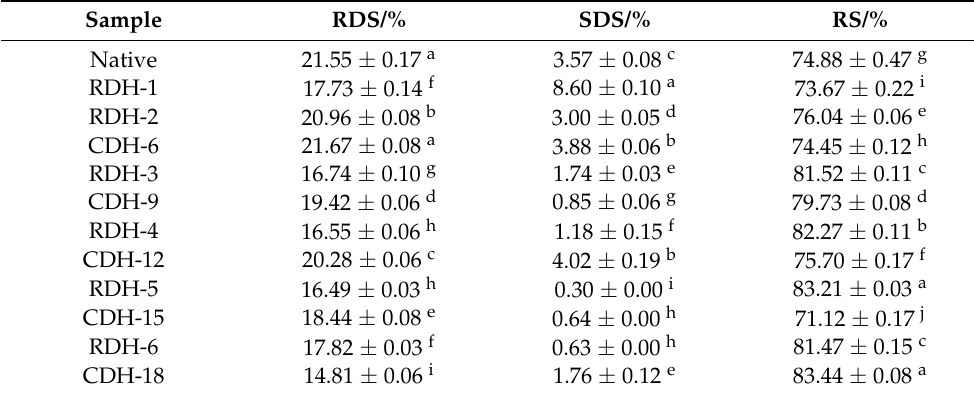
Table 4. RDS, SDS and RS of the native, RDH- and CDH-treated potato starch samples.